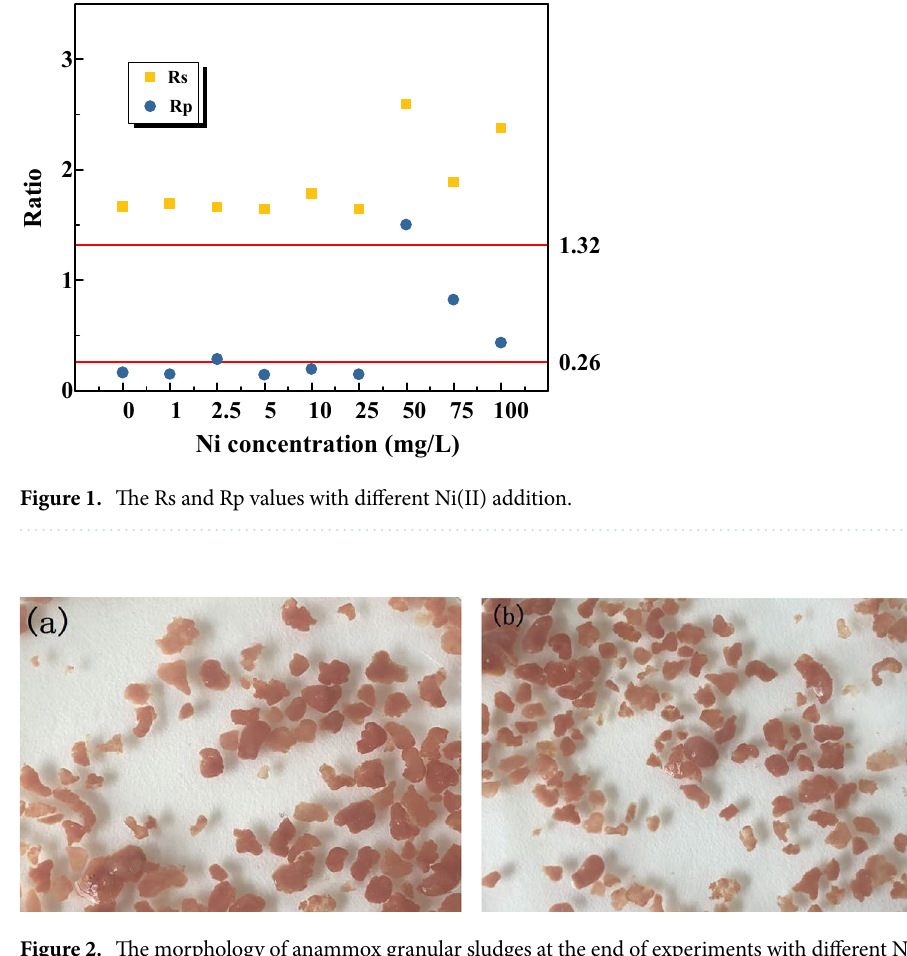
Figure 2. The morphology of anammox granular sludges at the end of experiments with different Ni(II) addition: 0 mg/L ( a ) and 25 mg/L ( b